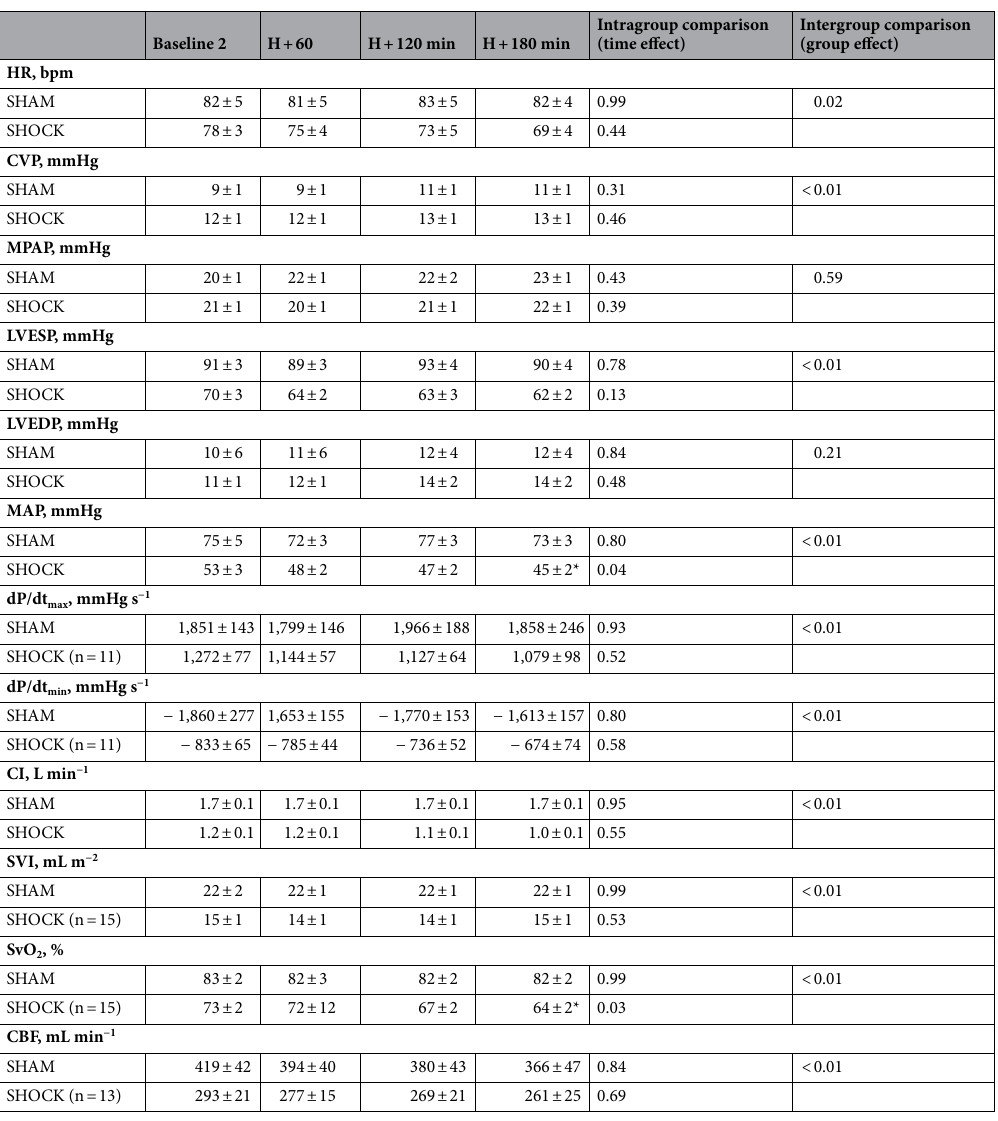
Table 2. Haemodynamic parameters during three consecutive hours from baseline 2 (cardiogenic shock). Data from n = 8 SHAM and n = 17 SHOCK independent experiments (if not otherwise mentioned), expressed as mean ± SE. Two-way ANOVA was performed for comparison of multiple means. * p<0.05 versus baseline 2. HR heart rate, CVP central venous pressure, MPAP mean pulmonary arterial pressure, LVESP left ventricular end systolic pressure, LVEDP left ventricular end diastolic pressure, MAP mean arterial pressure, dP/dt first derivative of left ventricular pressure, CI cardiac index, SVI stroke volume index, SvO 2 mixed venous oxygen saturation, CBF carotid blood